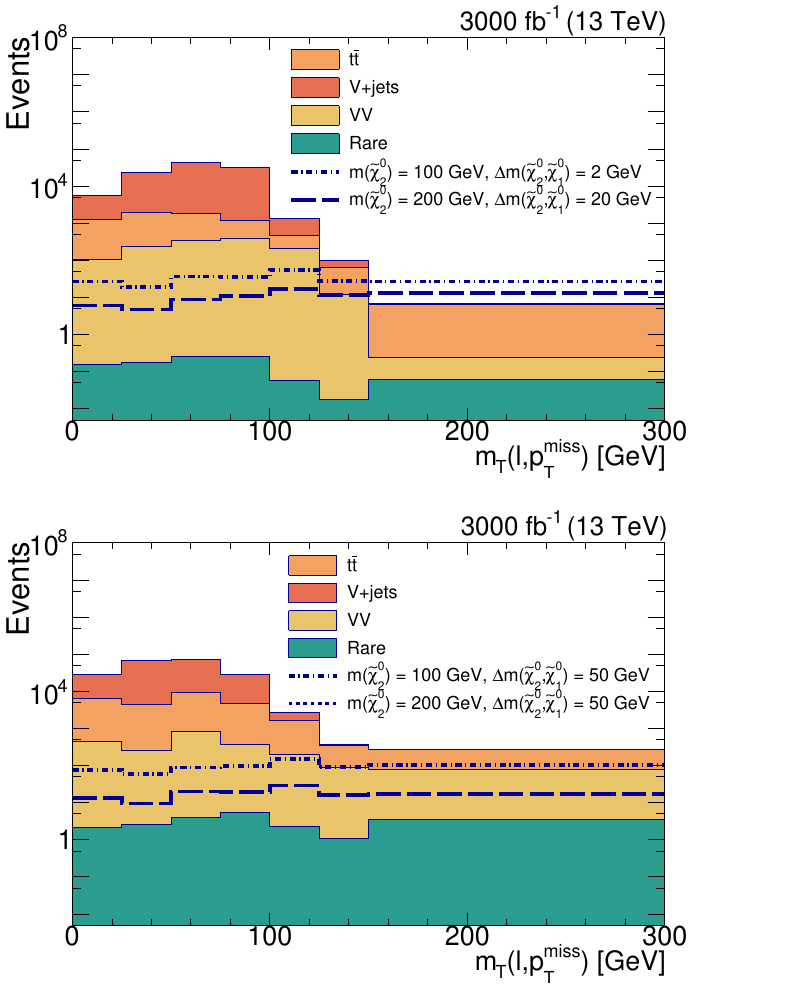
Figure 8 . The m T distributions in the single-lepton signal regions with p T ( l ) < 15 GeV (top) and p T ( l ) < 40 GeV